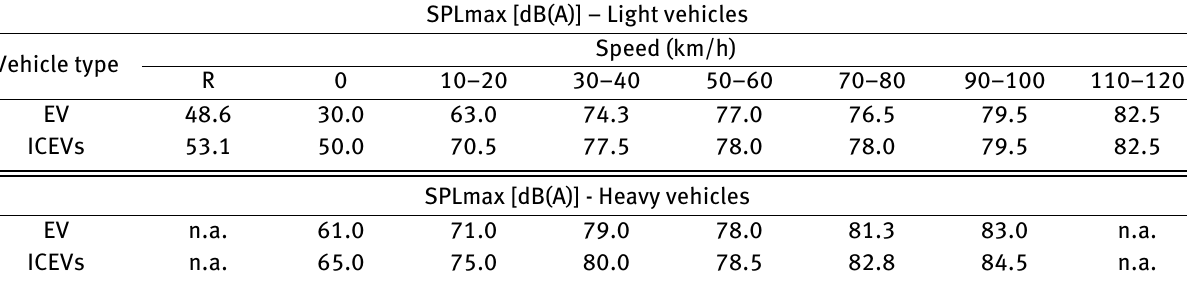
Table 1: Summary of the results of Task